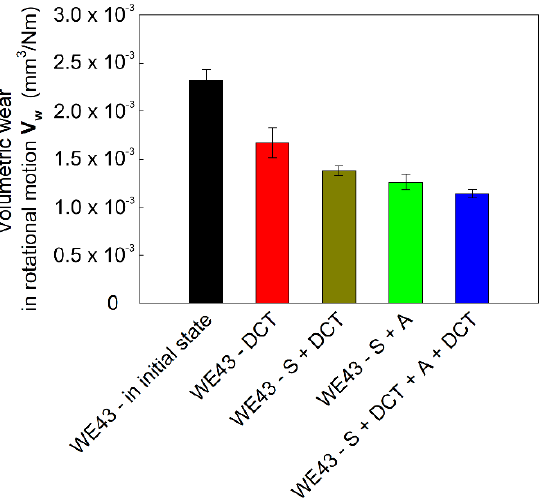
Figure 8. SEM microscope images and isometric 3D images of wear traces of WE43 magnesium alloy in the initial state ( a , b ) and after deep cryogenic treatment combined with precipitation hardening ( c , d ).